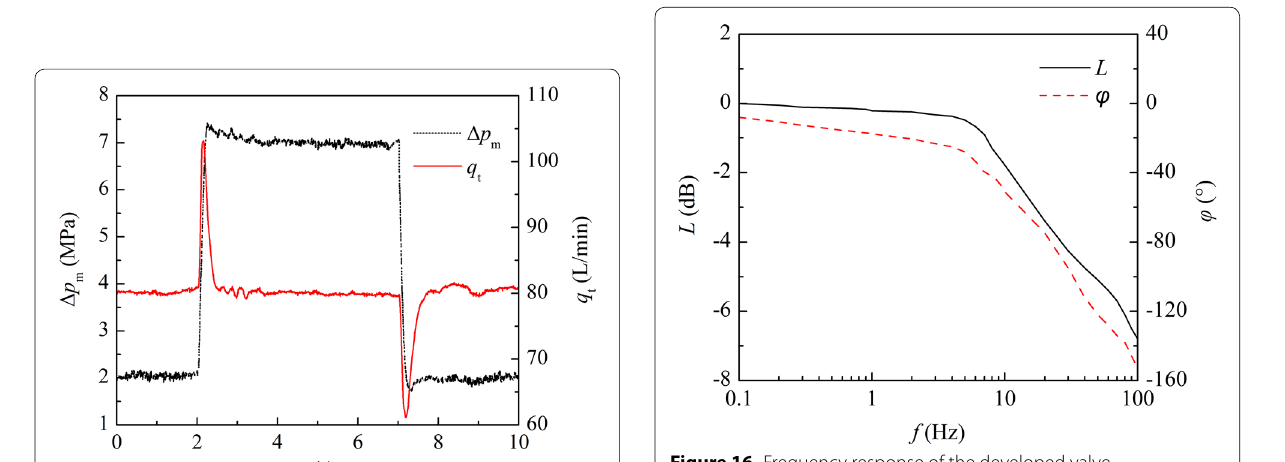
Figure 16 Frequency response of the developed